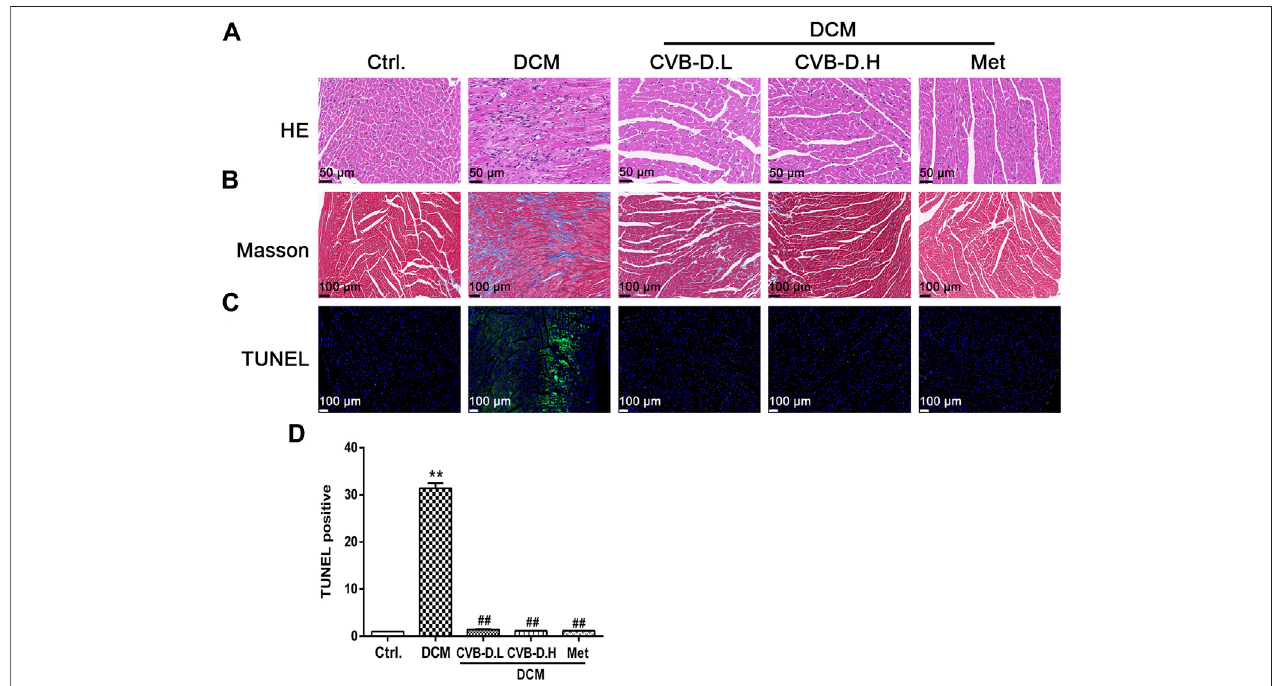
FIGURE 3 | CVB-D ameliorates the cardiac physiology changes in DCM mice. (A) HE (Hematoxylin-Eosin) staining of mice heart tissues. (B) Masson staining was performedinmicehearttissues. (C,D) In fl uenceofCVB-DonTUNELpositivecellnumber.Thedataarepresentedasthemean±SEM( n =6),* p < 0.05,** p < 0.01versus the control group; # p < 0.05, ## p < 0.01 versus the model